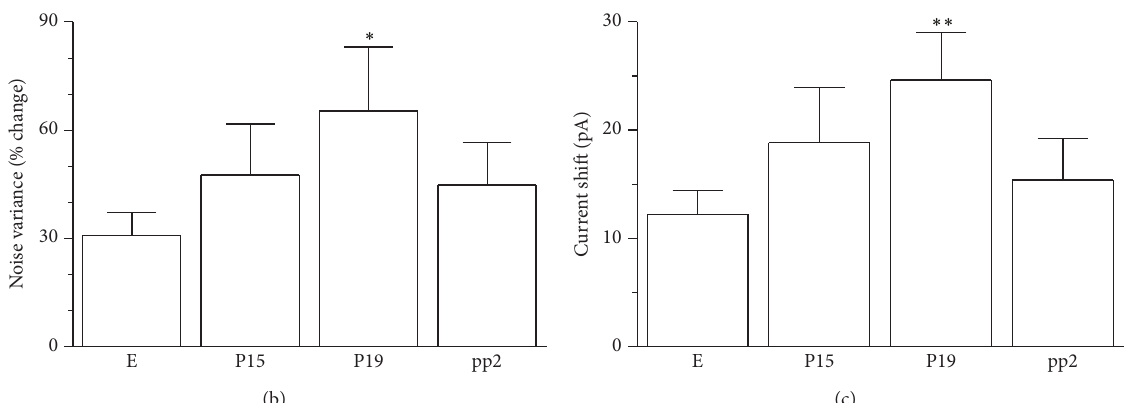
Figure 2: Changes in GABAergic tonic current in granule cells of the dentate gyrus during pregnancy and after delivery. (a) Representative traces (left) and all-point histogram (right) relative to GABAergic currents recorded in the whole-cell mode from granule cells of the dentate gyrus of hippocampal slices isolated from rats in estrus, at day P15 or P19, or at pp2. The effect of GABA (5 𝜇 M) and bicuculline (30 𝜇 M) is reported. Calibration: 50 pA, 2min. (b, c) Bar graphs summarizing the changes in noise variance (b) and holding current (c) induced by the application of exogenous GABA in experiments similar to those shown in (a). Adapted from Sanna et al., 2009 [34].